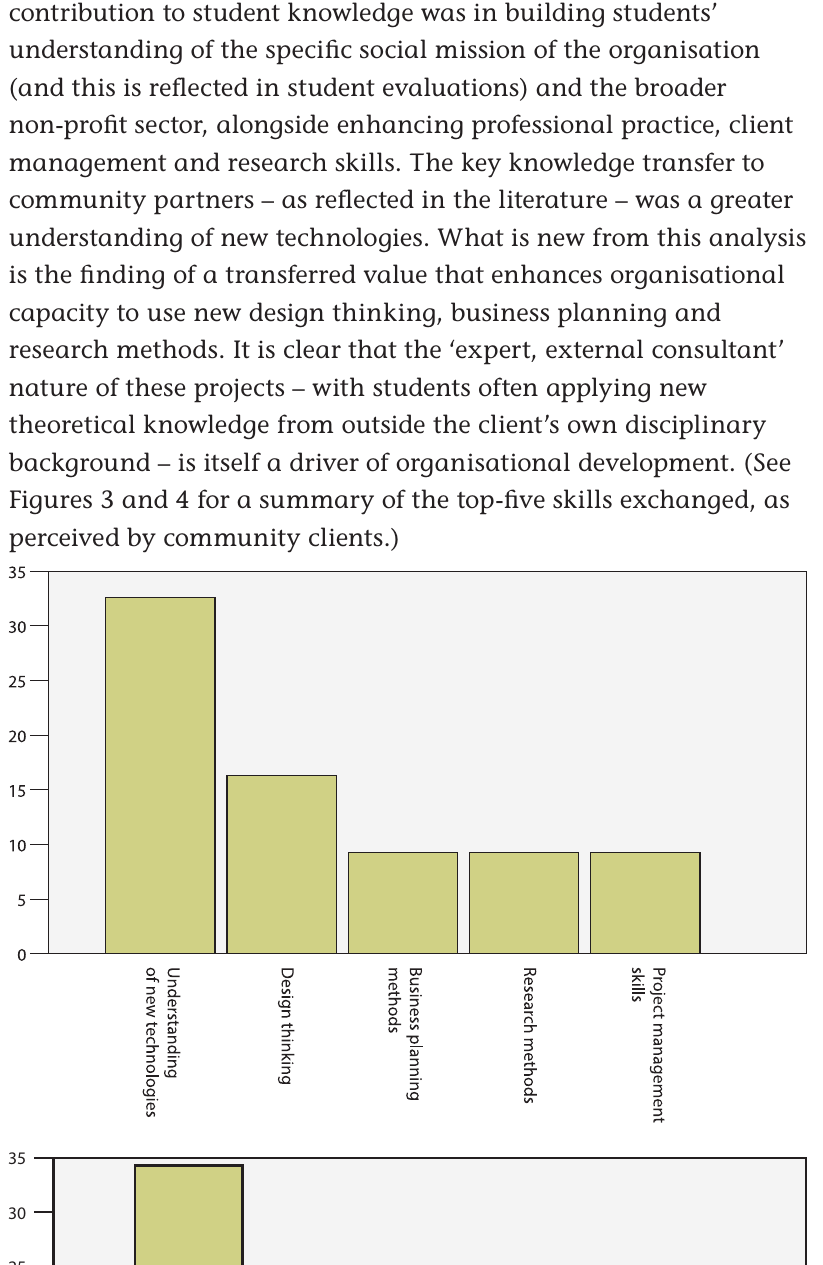
Figure 4: Top five